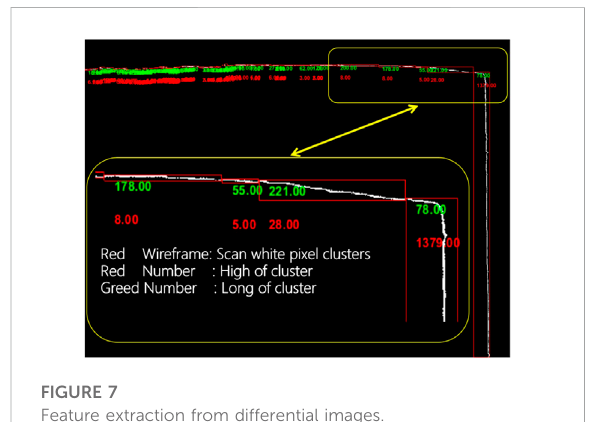
FIGURE 7 Feature extraction from differential